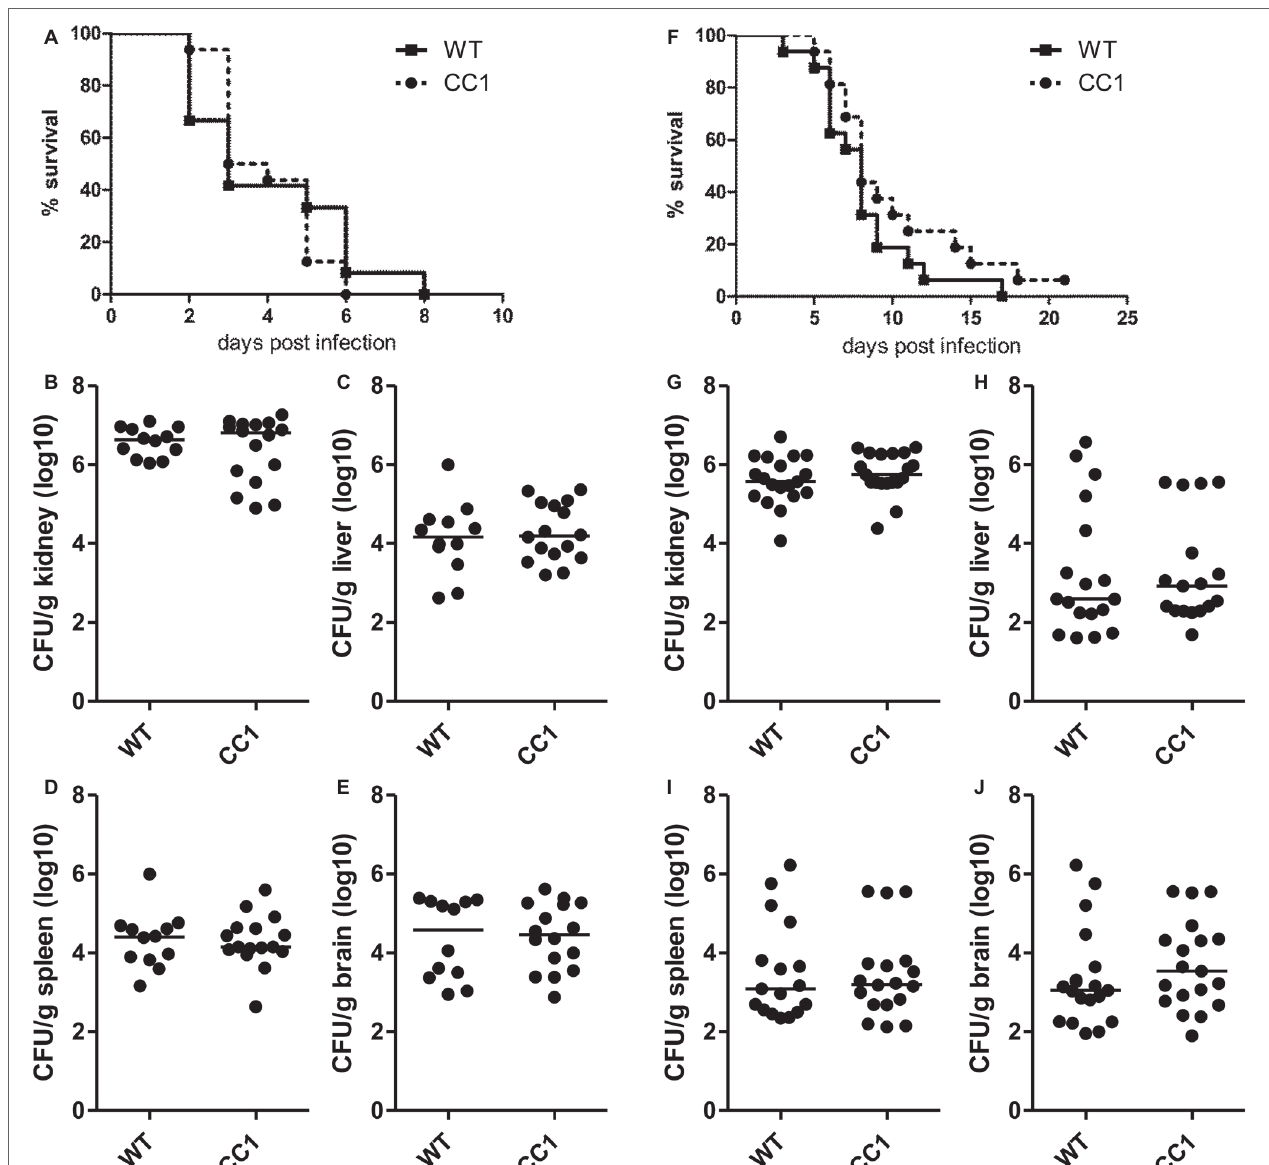
FIGURE 5 | The expression of human CEACAM1 does not affect the susceptibility for systemic candidiasis after tail vein injection. Human CEACAM1-transgenic mice (CC1) and their wild-type littermates (WT) were injected with 2.5 × 10 5 CFU C. albicans /g body weight ( A–E , corresponding to a total of 5 × 10 6 CFU for a mouse of 20 g body weight) or 1 × 10 5 CFU C. albicans /g body weight ( F–J , corresponding to a total of 2 × 10 6 CFU for a mouse of 20 g body weight) into the tail vein and sacrificed when reaching a humane endpoint. All graphs show combined data from two independent experiments with N = 12 (WT/ A–E ) or N = 16 (CC1/ A–E , WT/ F–J , CC1/ F–J ). (A,F) Survival analysis. Note that log-rank tests did not show any significant differences in the survival between the two genotypes for both infection doses ( A : p = 0.660, F : p = 0.177). Kidneys (B,G) , livers (C,H) , spleens (D,I) , and brains (E,J) were removed during necropsy, homogenized, and analyzed for their CFU content by plating dilutions on YPD/chloramphenicol agar. Graphs show CFU/g tissue (log10) with median. Statistical analyses (B–E,G–J) were performed with logarithmized data by non-paired, two-sided Student’s t tests ( B : p = 0.411, C : p = 0.626, D : p = 0.903, E : p = 0.850, G : p = 0.344, H : p = 0.908, I : p = 0.833, J : p =